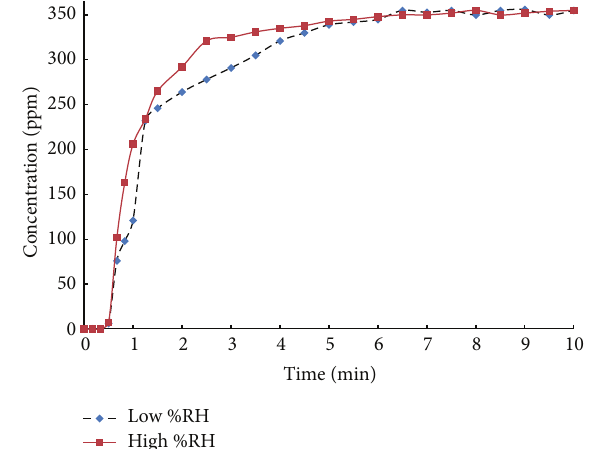
Figure 11: Effect of humidity on adsorption of CO 2 (high %RH = 80% and low %RH = 10%) onto fly ash. Reaction conditions: initial CO 2 concentration of 350 ppm, CO 2 /N 2 flow rate of 0.3 L/min, 1g ash, and 22 ∘